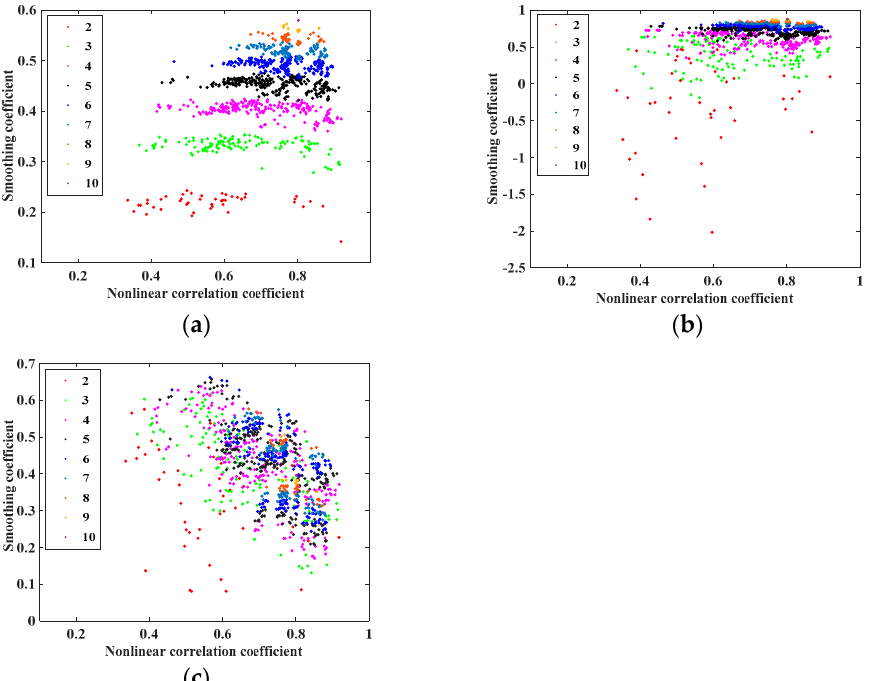
Figure 3. The smoothing coefficients under different wind farm combinations. ( a ) The volatility-based smoothing coefficient; ( b )The smoothing coefficient based on standard deviation; ( c ) The smoothing coefficient based on volatility confidence